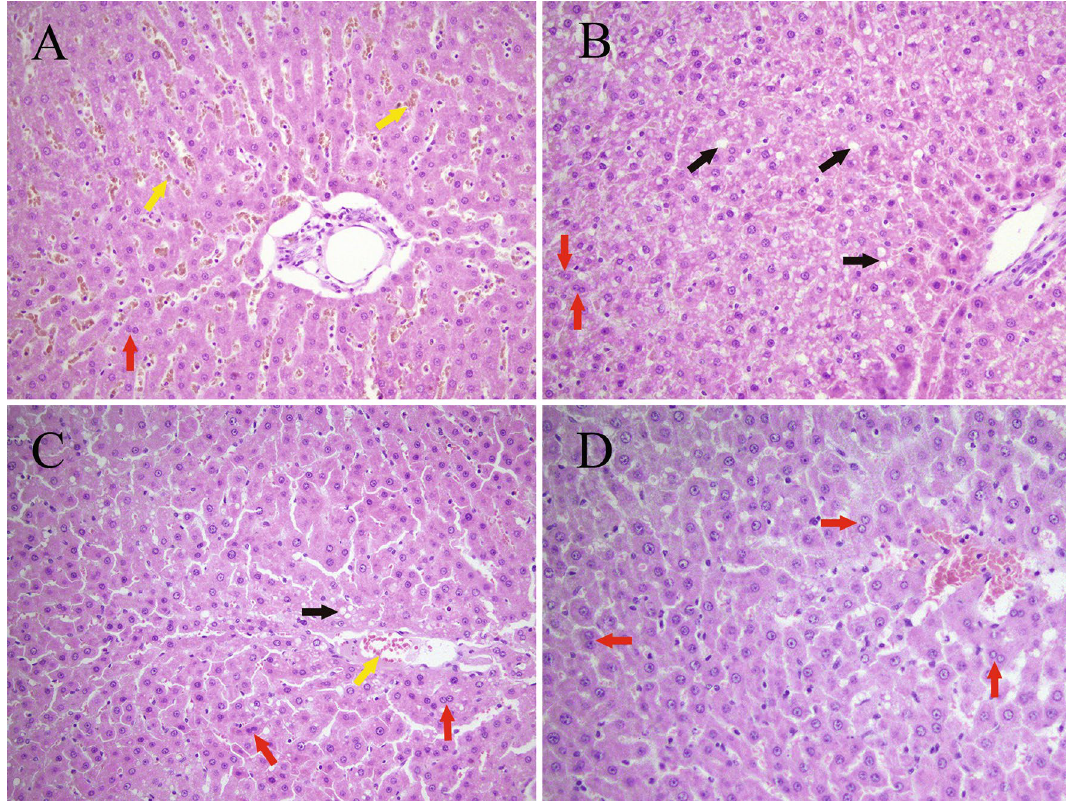
Figure 2. Liver histology analysis (H&E stain, 40 ×). Experimental group abbreviations: ( A ) sham-operated (S) rat group, ( B ) sham-operated + meldonium (S + M) group, ( C ) ischemia/reperfusion (I/R) rat group, ( D ) ischemia/reperfusion + meldonium (I/R + M) rat group. Yellow arrow—erythrocytic extravasation into sinusoidal spaces; black arrow—vacuolar degeneration; red arrow—binuclear hepatocytes.